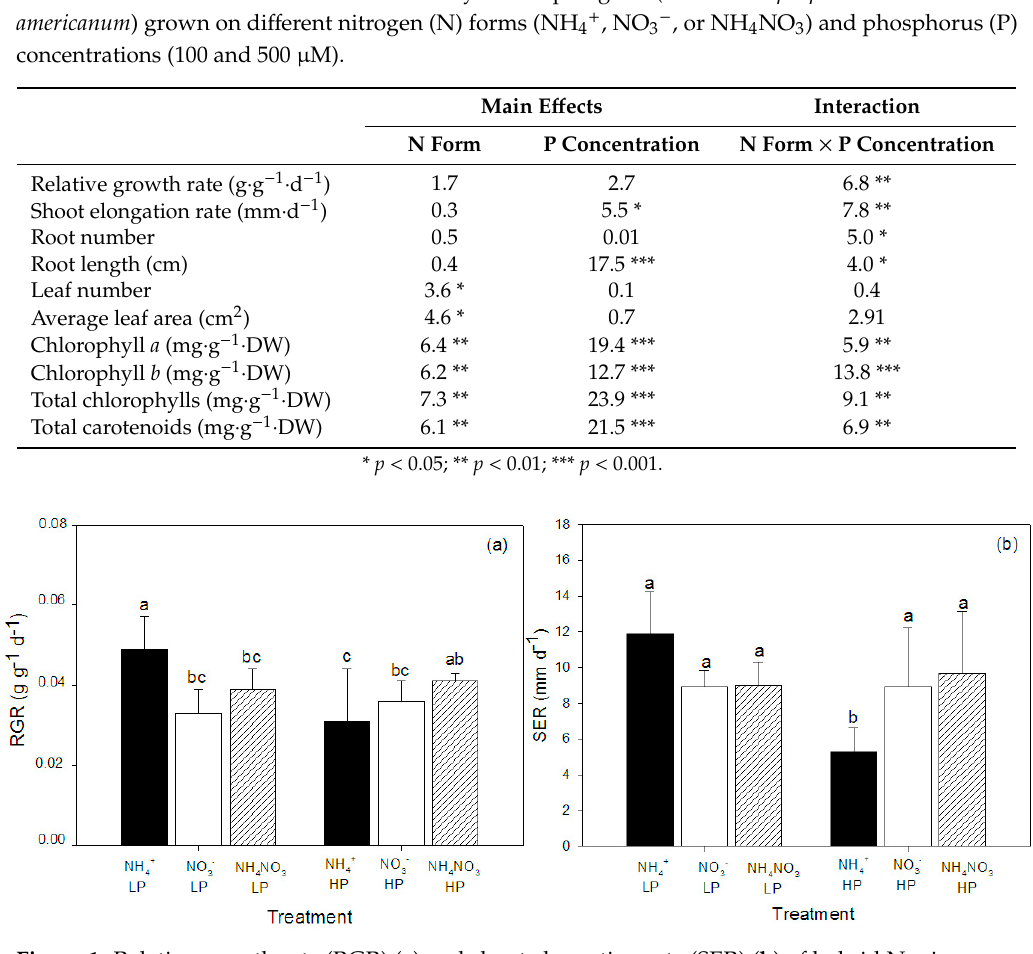
Figure 1. Relative growth rate (RGR) ( a ) and shoot elongation rate (SER) ( b ) of hybrid Napier grass ( Pennisetum purpureum × P. americanum ) (mean ± SD) grown on di ff erent N forms (NH 4 + , NO 3 − , ( Pennisetum purpureum × P. americanum ) (mean ± SD) grown on different N forms (NH 4+ , NO 3 − , and and NH 4 NO 3 ) and P concentrations (LP, low P concentration (100 µ M P); HP, high P concentration NH 4 NO 3 ) and P concentrations (LP, low P concentration (100 µM P); HP, high P concentration (500 (500 µ M P)). Di ff erent letters above columns indicate significant di ff erences between µM P)). Different letters above columns indicate significant differences between treatments.